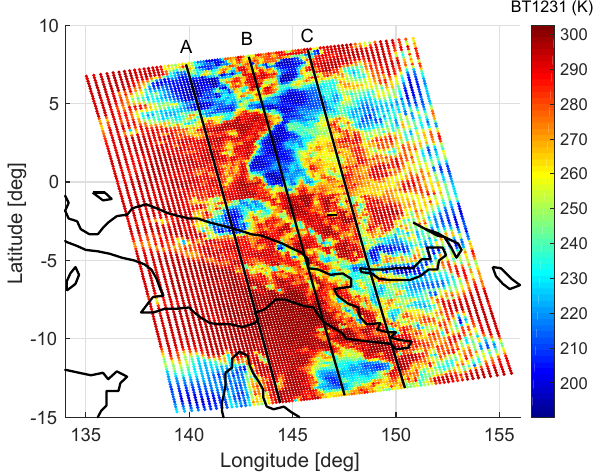
Figure 9. The 1231cm − 1 observed brightness temperatures for Granule 039 on 11 March 2011.